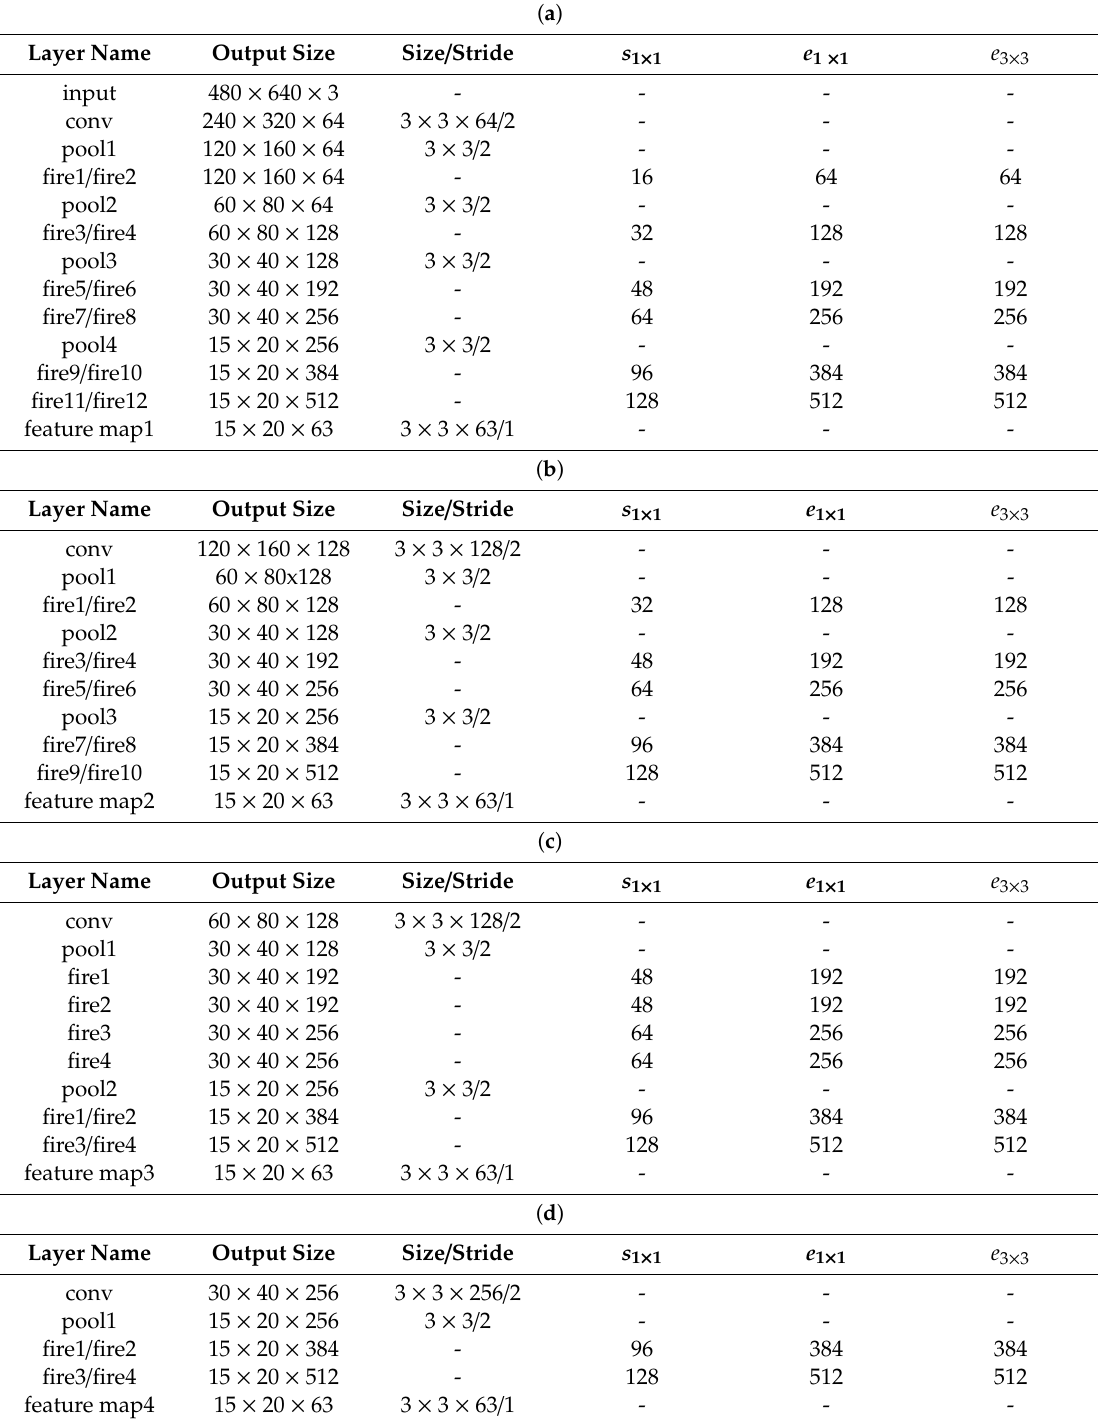
Table 1. The detailed parameters of each branch. ( a ) Branch-1; ( b ) Branch-2.; ( c ) Branch-3; ( d ) Branch-4. ( a